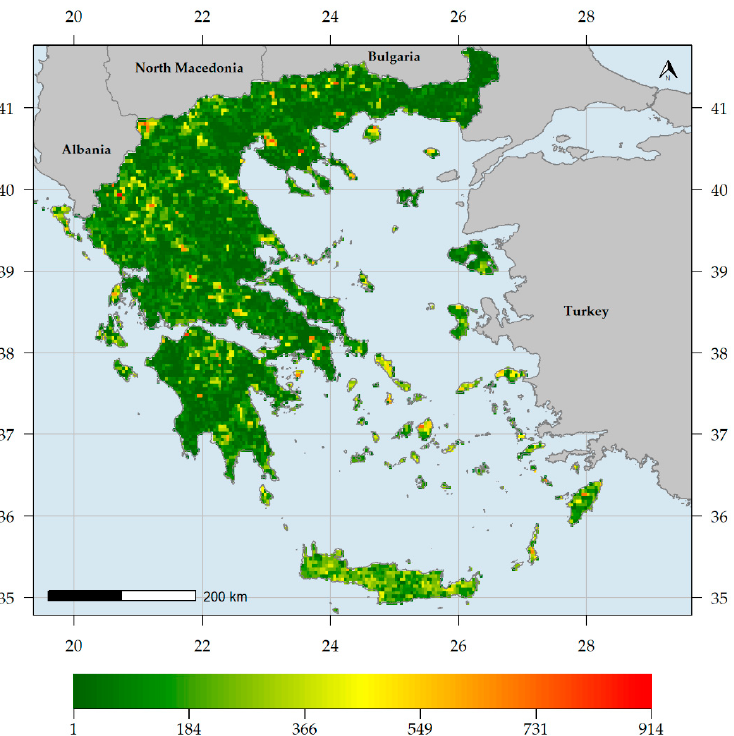
Figure 3. Native plant species richness in Greece (number of native plant species per grid cell).